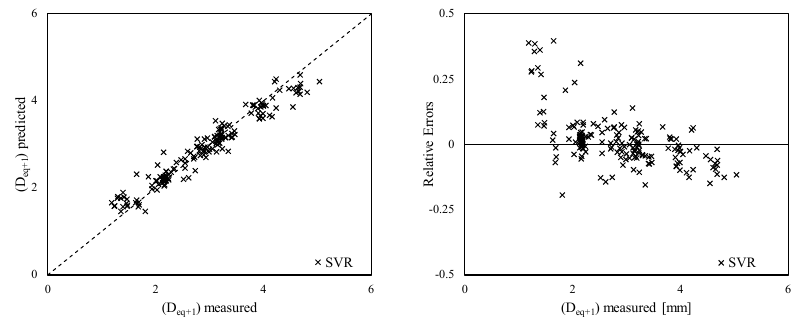
Figure 6. Equivalent diameter prediction “Model 1”: in the left column, predicted versus experimental values, in the right column, residuals versus experimental values.